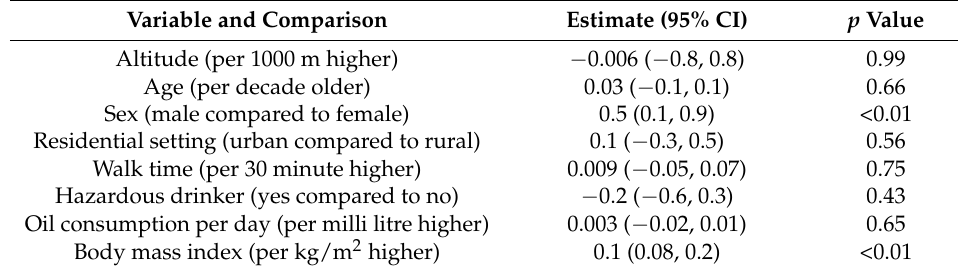
Table A2. Estimates of the mean total cholesterol to high-density lipoprotein cholesterol (TC to HDL) ratio for altitude in a multivariate ANCOVA and associations for confounding